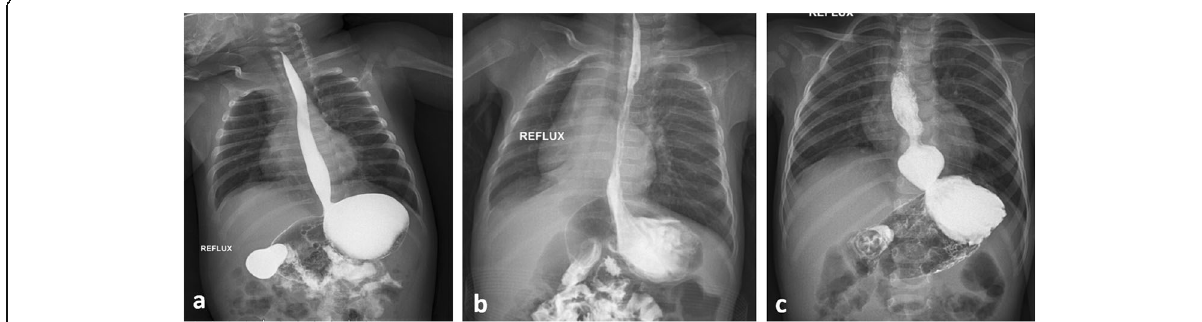
Fig. 2 Different patterns of gastroesophageal reflux a ) idiopathic reflux reaching up to the level of upper esophagus; b ) reflux associated with organoaxial gastric volvulus; c ) reflux associated with sliding hiatus